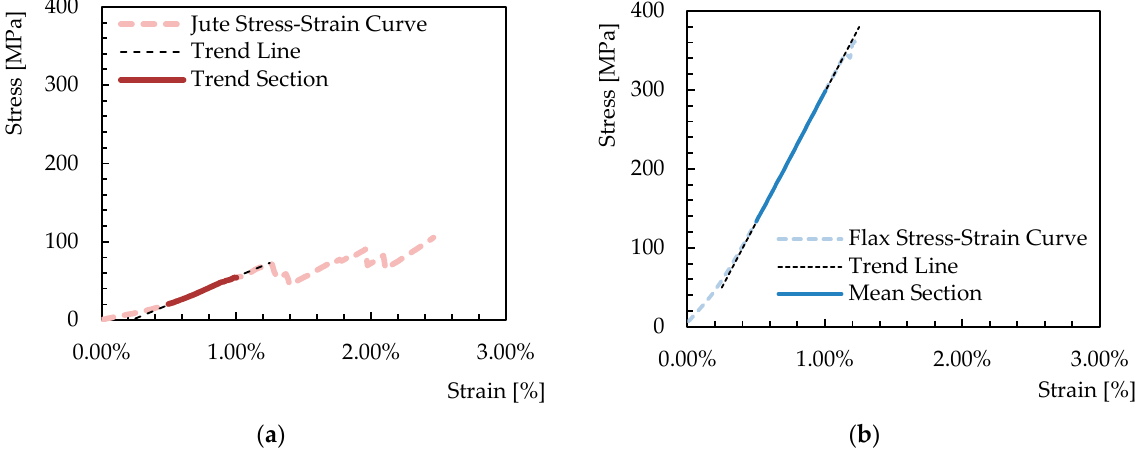
Figure 10. Stress–strain curves and linear branch from which Young’s modulus was determined for Jute ( a ) and Flax ( b ) fabrics.